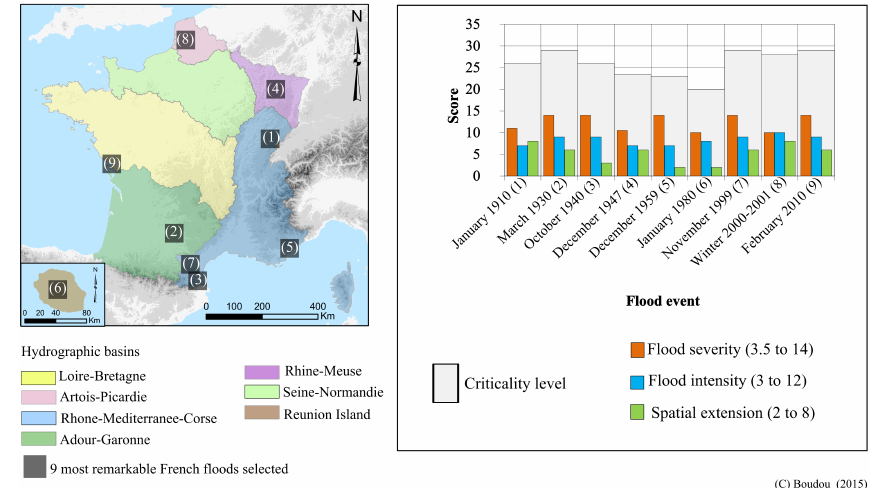
Figure 1. Location map of the nine most remarkable French flood events selected in this study and chart showing their related remarkability scores (Boudou, 2015).